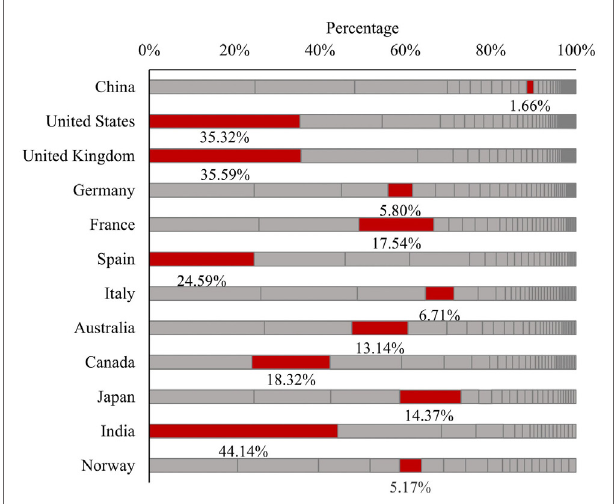
FigUre 2 | Tweeters from other countries